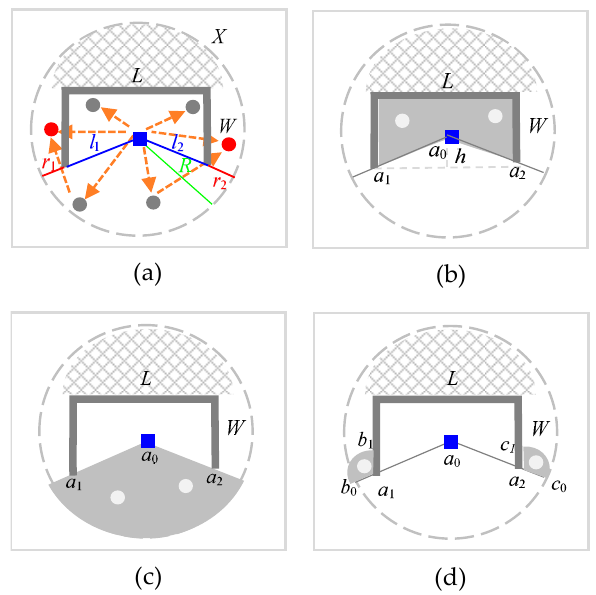
Figure 7. n -shaped layout. ( a ) Radiation of power density distribution. ( b ) Local, ( c ) direct, and ( d ) semidirect effects.